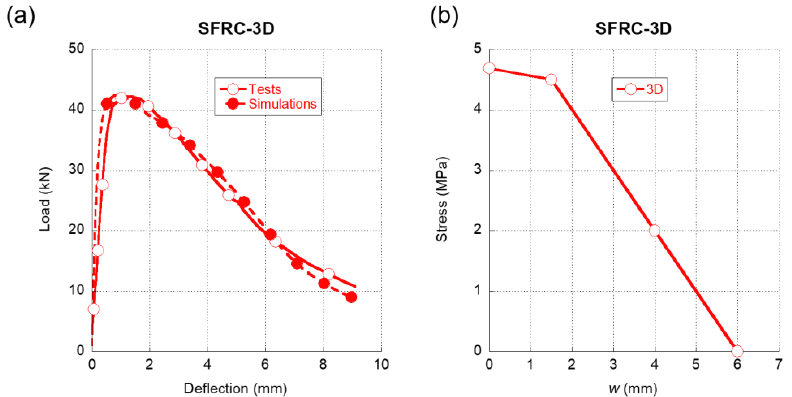
Figure 5. ( a ) Comparison of the average experimental results obtained in the fracture tests of SFRC-3D and the numerical simulation. ( b ) Softening function used in the simulation shown in ( a